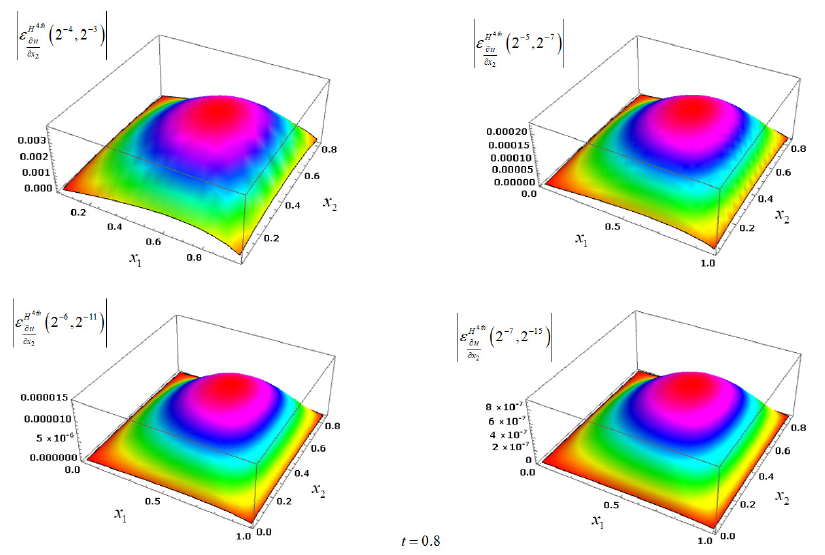
(cid:16) (cid:17) ∂ u for ∂ x 2